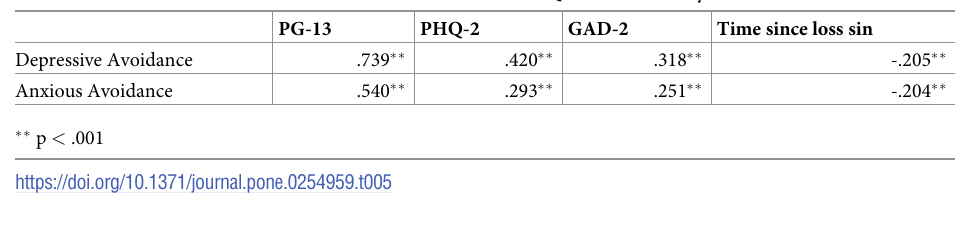
total sample, both subscales were positively skewed. The kurtosis for DA was also positive, for AA slightly negative. Cronbach’s α was .95 for DA, and .86 for AA.